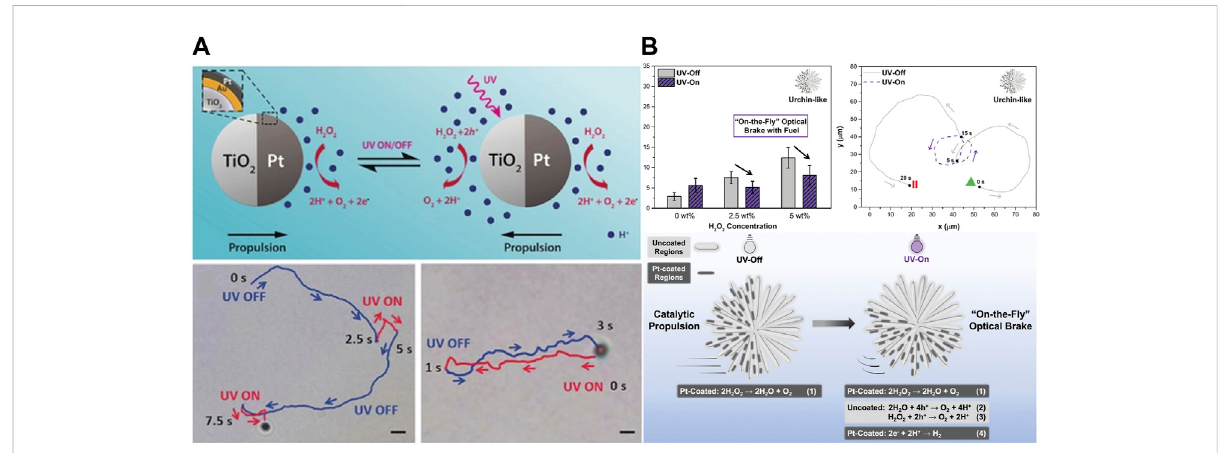
FIGURE 7 Examples ofmicrorobotswithopticalbrakes. (A) Abalanceofcatalytic(Ptside)andoptical(TiO 2 side)reactionstohaltthemotion.Reproduced with permission (Chen et al., 2018b) Copyright 2018 Wiley-VCH. (B) Motion and on-the- fl y optical brakes are achieved by shape engineering of urchin-like